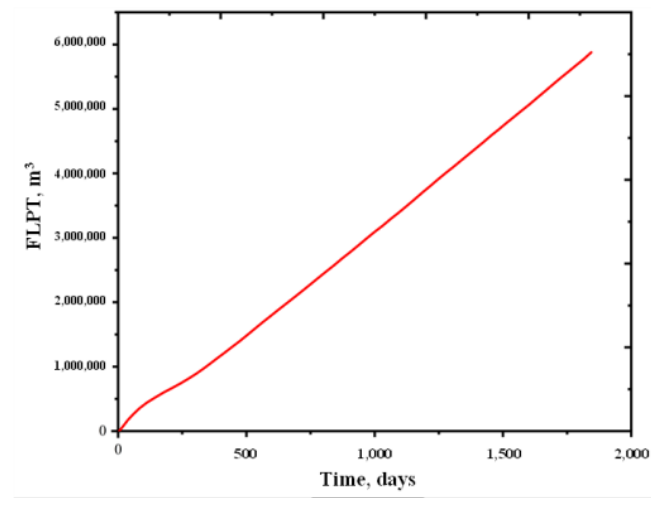
Figure 12. Field liquid production rate for horizontal well.